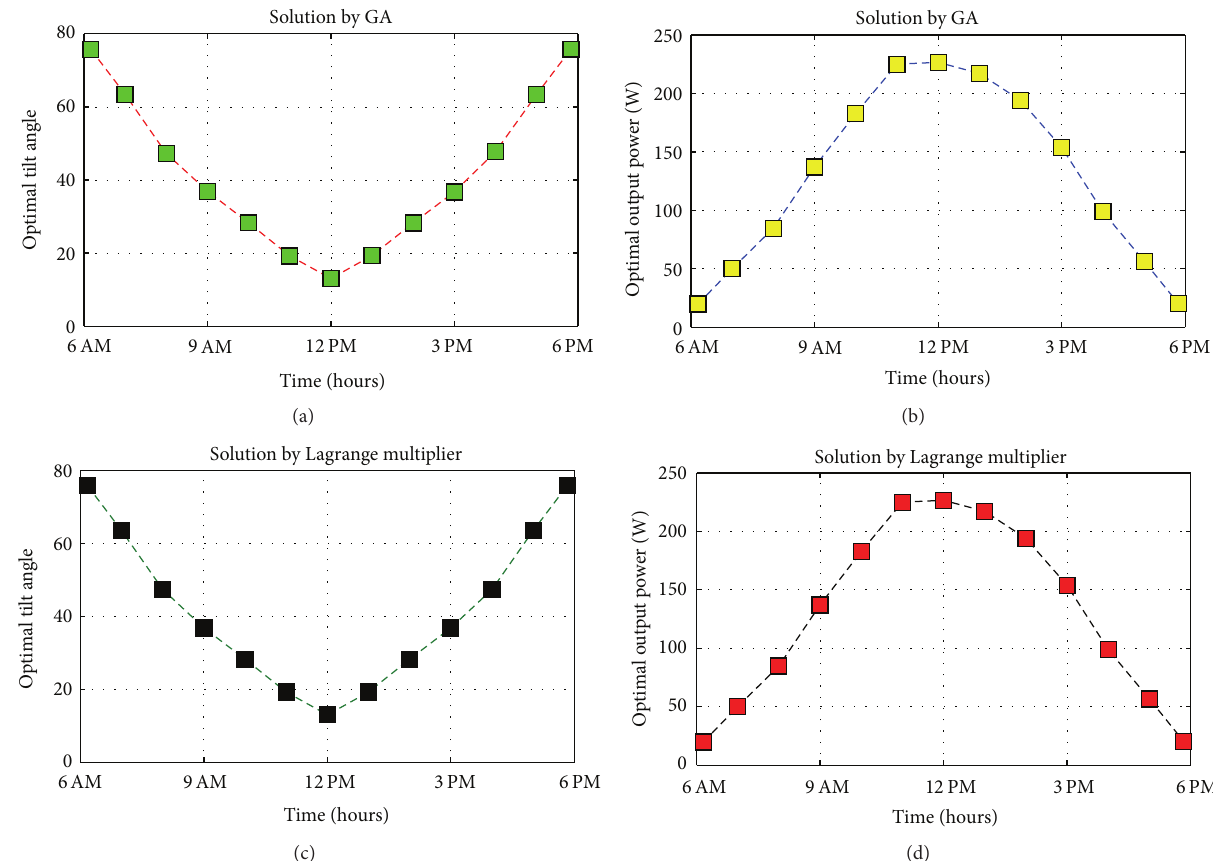
Figure 15: A comparison between the GA and Lagrange multiplier algorithm